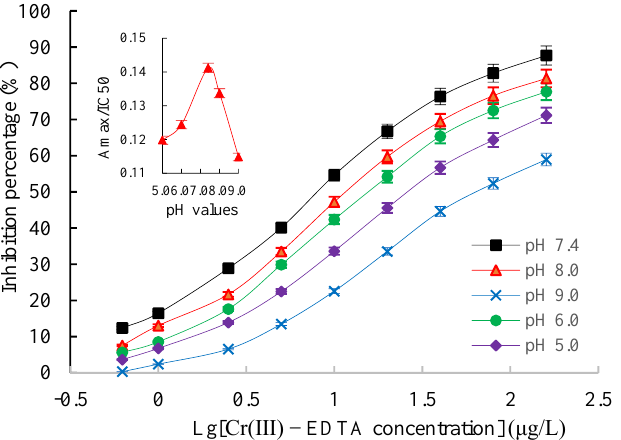
Figure 8. The effects of pH value on an icELISA. Insets indicate the fluctuations of Amax/IC50 as a function of pH value.